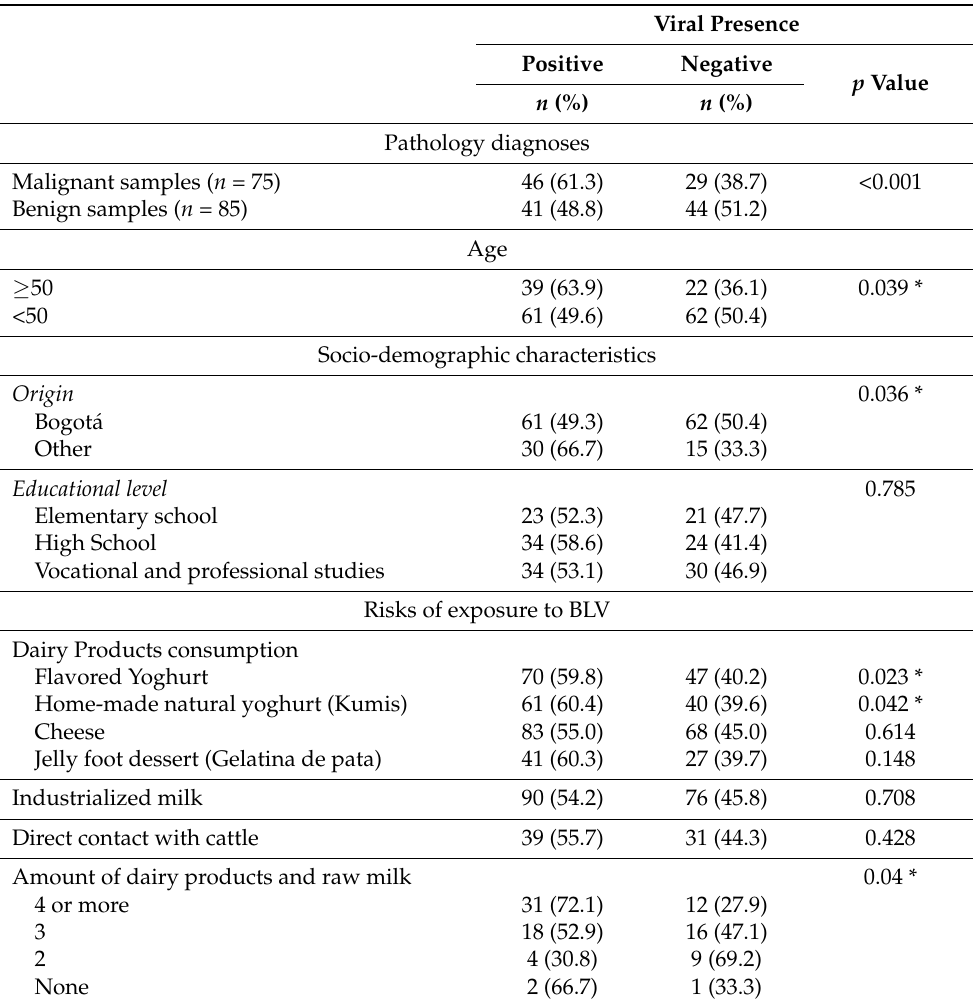
Table 1. Sociodemographic characteristics of female participants and exposure factors to BLV. Bi- variate analysis comparing the presence of the virus with the exposure